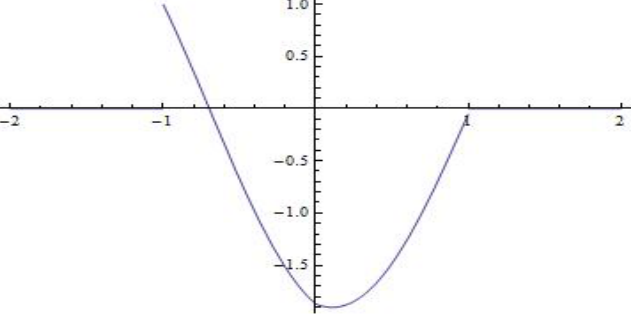
Figure 2. Graph of the first fundamental solution y = φ ( x , λ ) , for λ = 3. (This graph was sketched by using “Mathematica